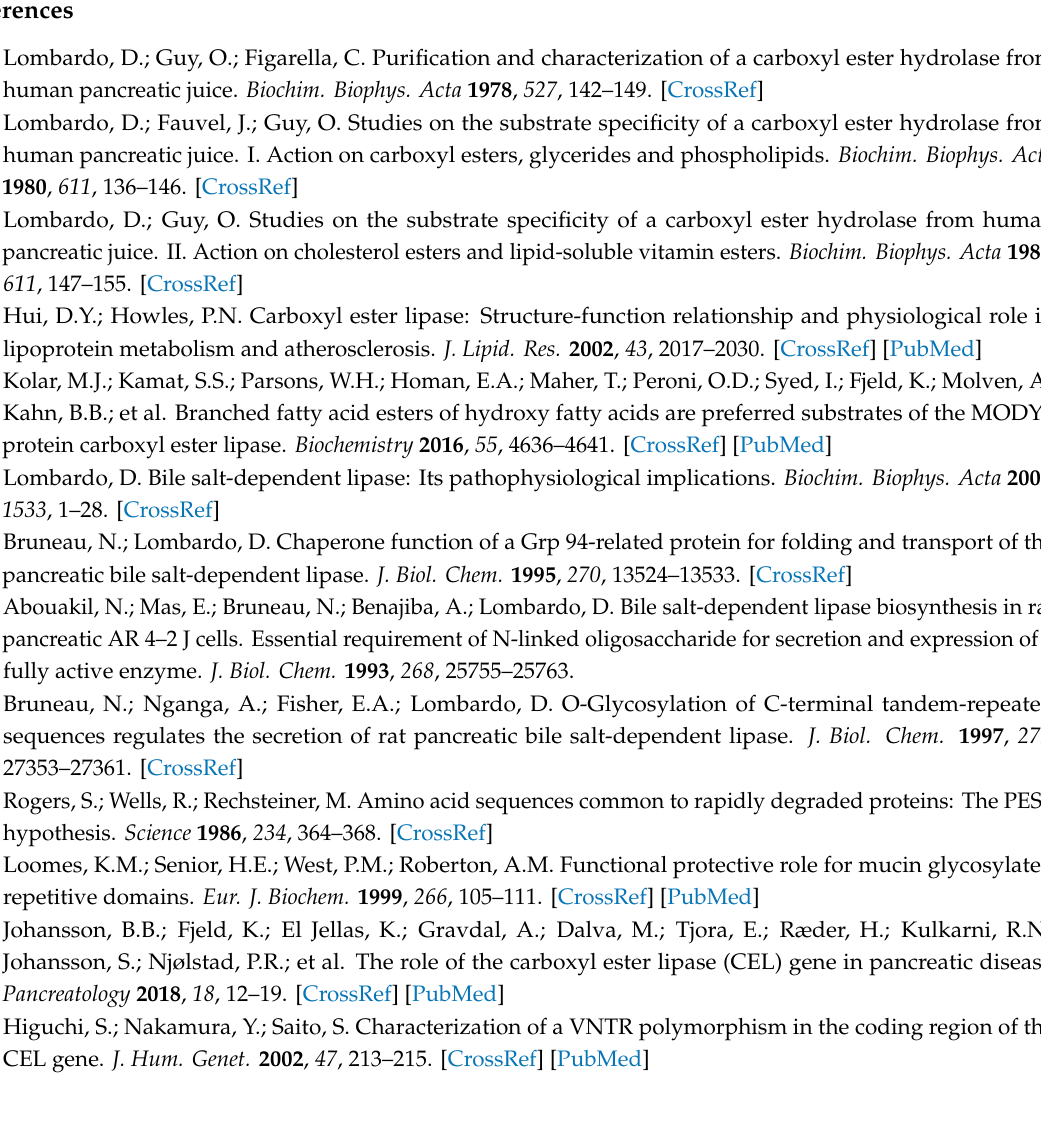
Figure S1: Representative western blot showing varying secretion of CEL protein variants into the